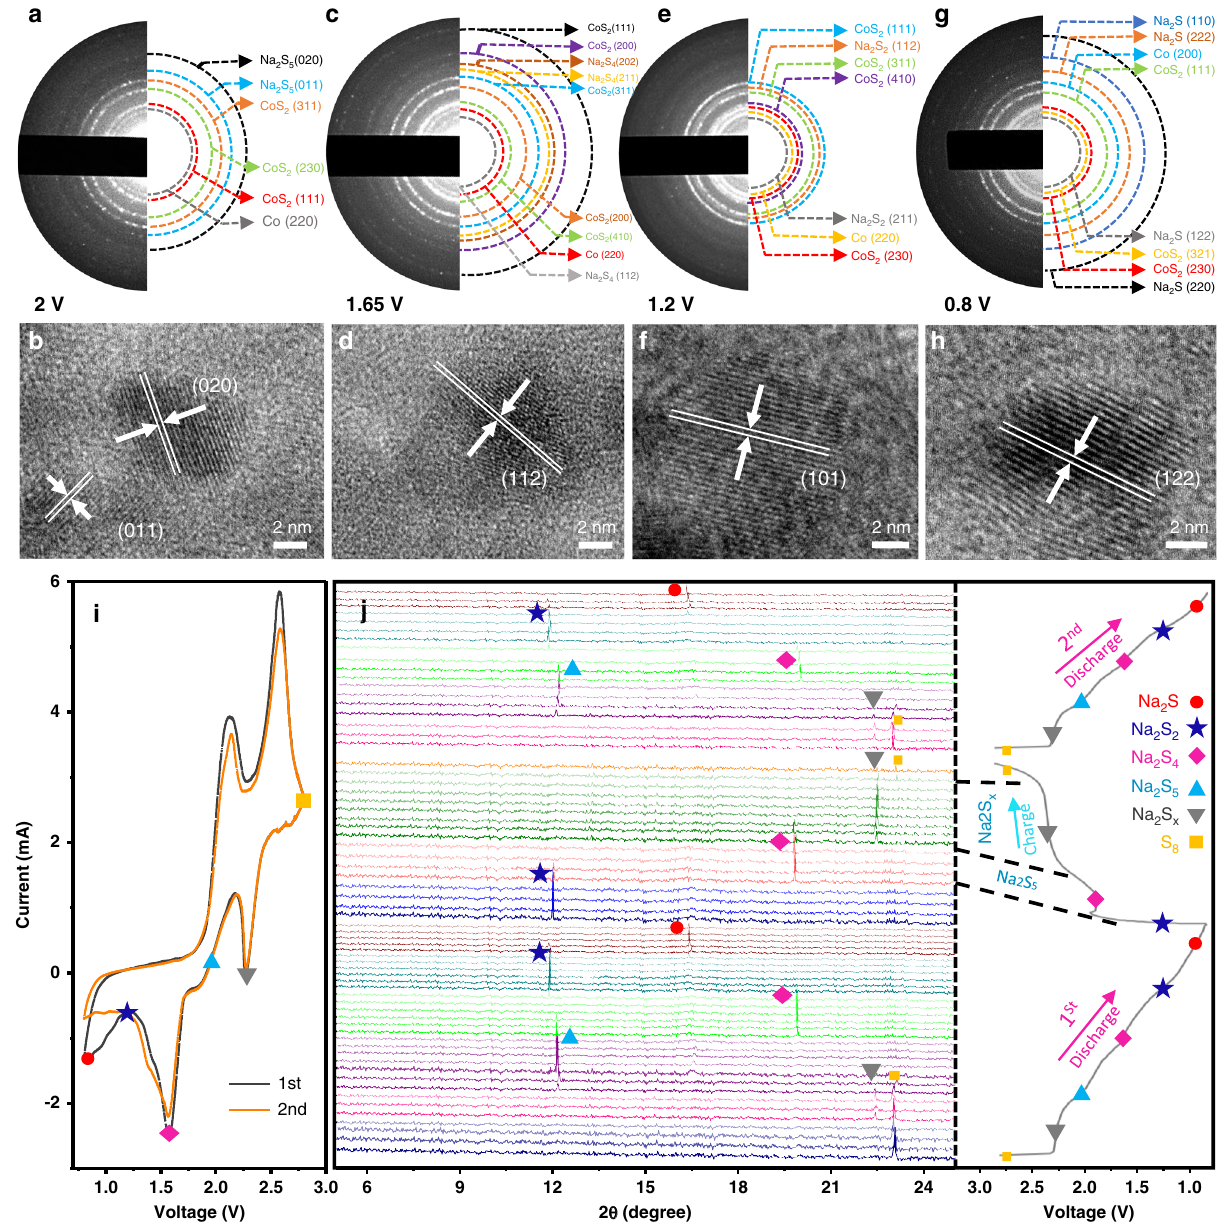
Fig. 5 HRTEM images and SAED patterns of S@BPCS electrode at different discharge voltages. a SAED pattern and b corresponding HRTEM at 2 V. c SAED pattern and d corresponding HRTEM at 1.65 V; e SAED pattern and f corresponding HRTEM at 1.2 V and g SAED pattern and h corresponding HRTEM at 0.8 V; mechanistic characterization of the S@BPCS electrode. i Cyclic voltammogram. j In situ X-rays diffraction (XRD) patters in the selected range of degree 2-theta (right) with fi rst two charge – discharge pro fi les at a current density of 0.5